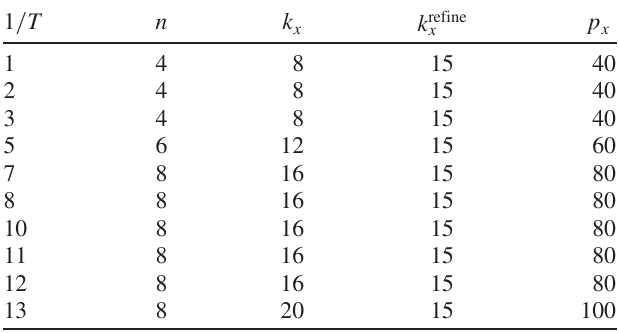
TABLE II. Technical parameters for the fRG calculations for all temperatures, performed with a smooth frequency cutoff. Here, n is the number of positive fermionic frequencies that determine the parametrization of the two-particle vertex (see Ref. [150] for the definitions). The rest function contains ð 4 n þ 1 Þ × ð 2 n Þ × ð 2 n Þ , the K 2 -function and the fermion-boson vertex ð 4 n þ 1 Þ × ð 2 n Þ , the K 1 -function ( 128 n þ 1 ), and the self-energy ð 8 n Þ